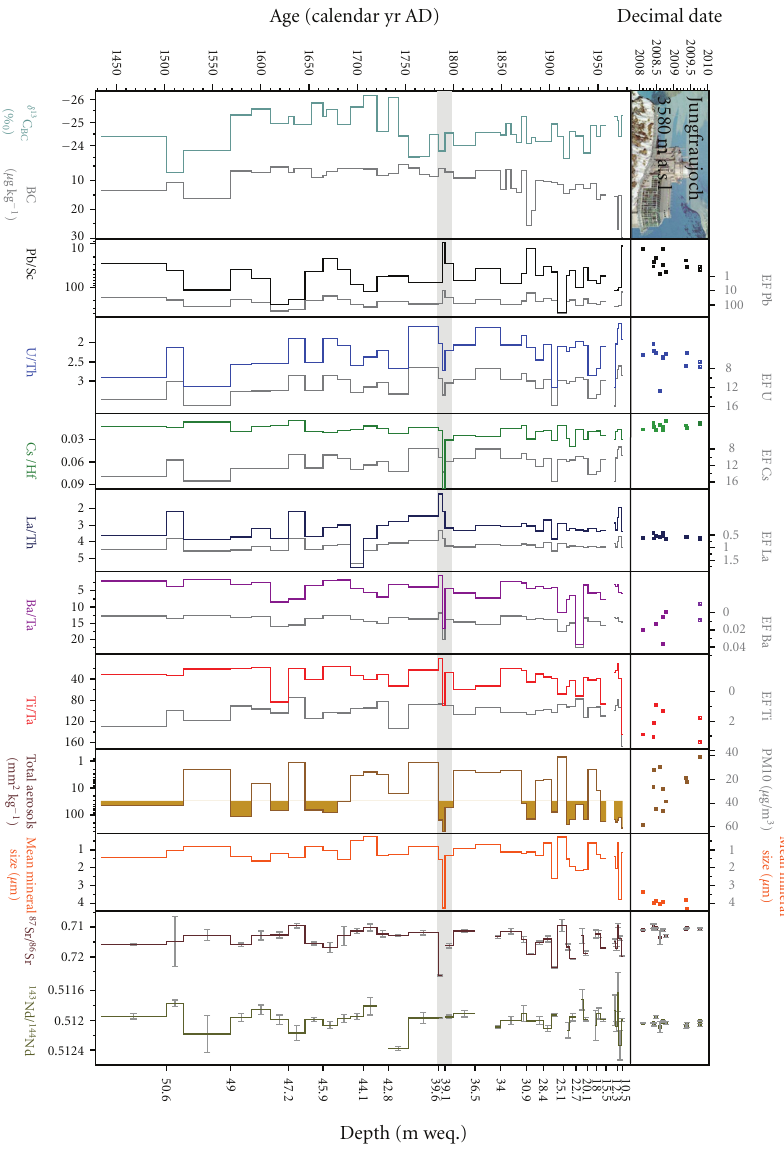
Depth (m weq.) Figure 2: (Left Insert) Aerial view of the Jungfraujoch (JFJ) research station. The record of black carbon (BC) concentration and the associated δ 13 C BC composition (data from [4]), as a function of age (calendar year AD; left axis) and depth (meter water equivalent, mweq.; right axis). Trace element concentrations (Pb, Ti, Ba, Cs, U, and La) normalized to conservative crustal elements (Sc, Ta, Hf, or Th) and crustal enrichment factors (EFs) after normalization to the mean concentration ratios in the upper continental crust [23]. The total aerosols surface (cuto ff level of 30mm 2 kg − 1 ) and the mean diameter of the mineral fraction [4] compared to Sr and Nd isotopic ratios. The analyses of analog samples collected during the years 2008/2009 at the JFJ are reported in the upper part. 87 Sr/ 86 Sr error bars (2 standard errors of the mean) have been multiplied by 5 for CG samples and by 10 for JFJ samples. The horizontal grey-shaded area highlights the largest Saharan dust event deposited ∼ 10 years before the Laki eruption in